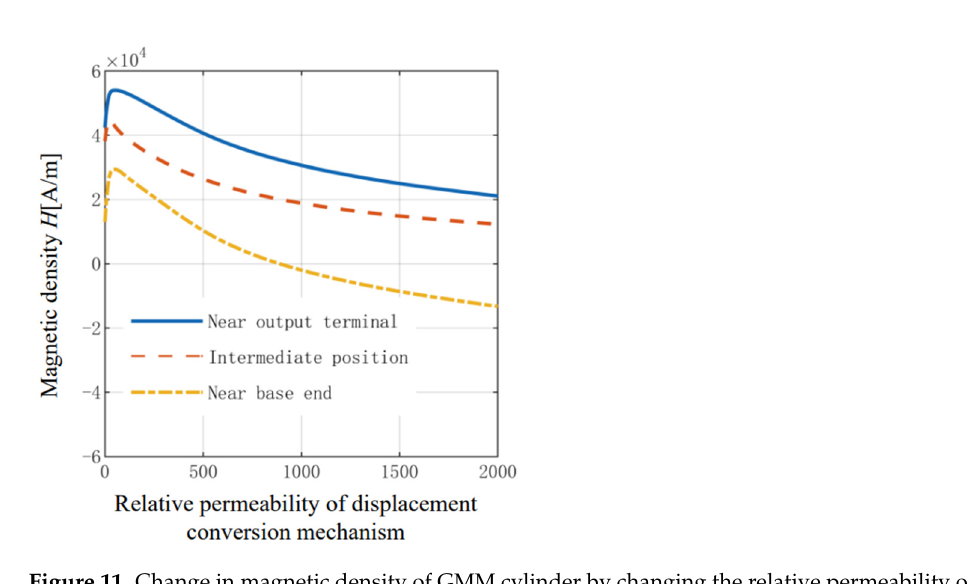
Figure 11. Change in magnetic density of GMM cylinder by changing the relative permeability of the displacement conversion mechanism.